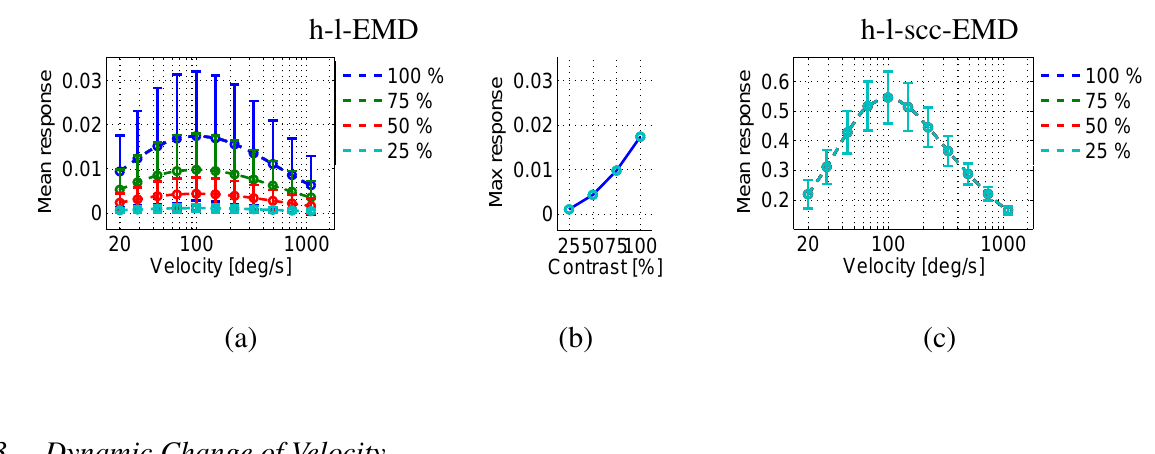
Figure 11. Velocity tuning curves of the h-l-EMD array and the h-l-scc-EMD array for different global contrasts. The contrast of the park scene panorama (Figure 4, no. 1) was set to 100%, 75%, 50%, and 25% respectively. The response of the h-l-EMD array ( a ) shows the quadratic contrast dependence ( b ). In the responses of the h-l-scc-EMD ( c ) the contrast dependency is eliminated almost completely (curves are identical for all contrast